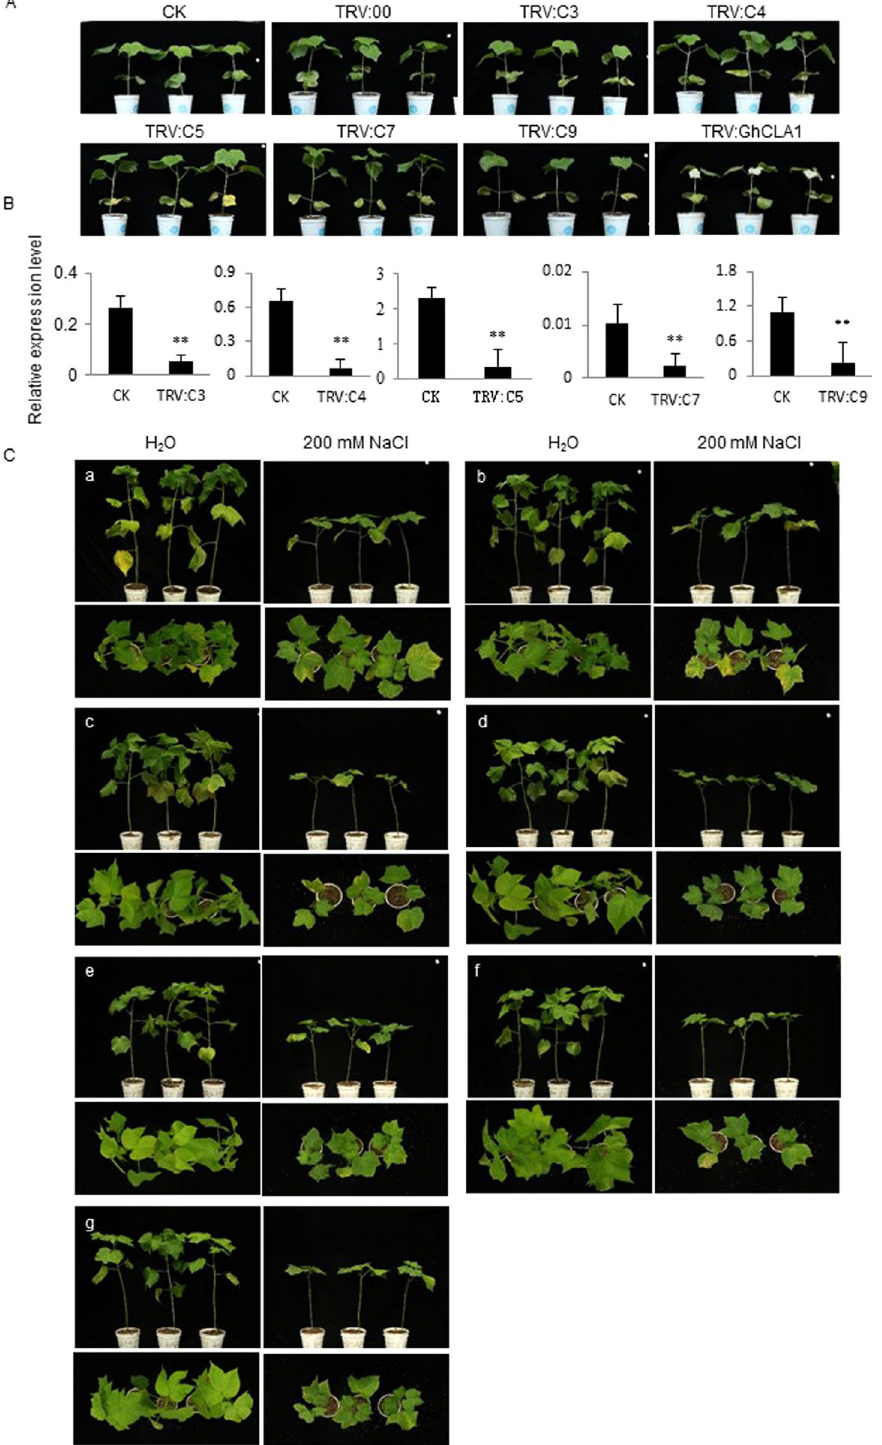
Figure 5. Plant phenotypes after target genes silencing with salt and mock treatments. ( A ) After two weeks infiltrated with TRV2: target silenced genes, the treated plants exhibited normal growth. TRV2: GhCLA1 plants exhibited a photobleaching phenotype as indicator. TRV: 00 as the mock treatment and no-infiltration plants as CK. ( B ) Gene expression of five candidate genes in silenced and control plant leaves by real-time PCR analysis. The error bars were calculated based on three biological replicates using standard deviation. The cotton beta-tubulin gene ( GhTub1 ) was used as the reference gene. “ * ” at P < 0.05, “ ** ” at P < 0.01. ( C ) Phenotypes of target gene- silenced and control plants after the salt stress treatment. Plants were treated with 200 mM NaCl for a month (H 2 0 as control). a-g indicate CK (no-infiltration), TRV:00 (mock treatment), TRV:C3, TRV: C4 , TRV: C5 , TRV: C7 and TRV: C9 , respectively. Upper: photographed from plants side; Below: photographed from plants